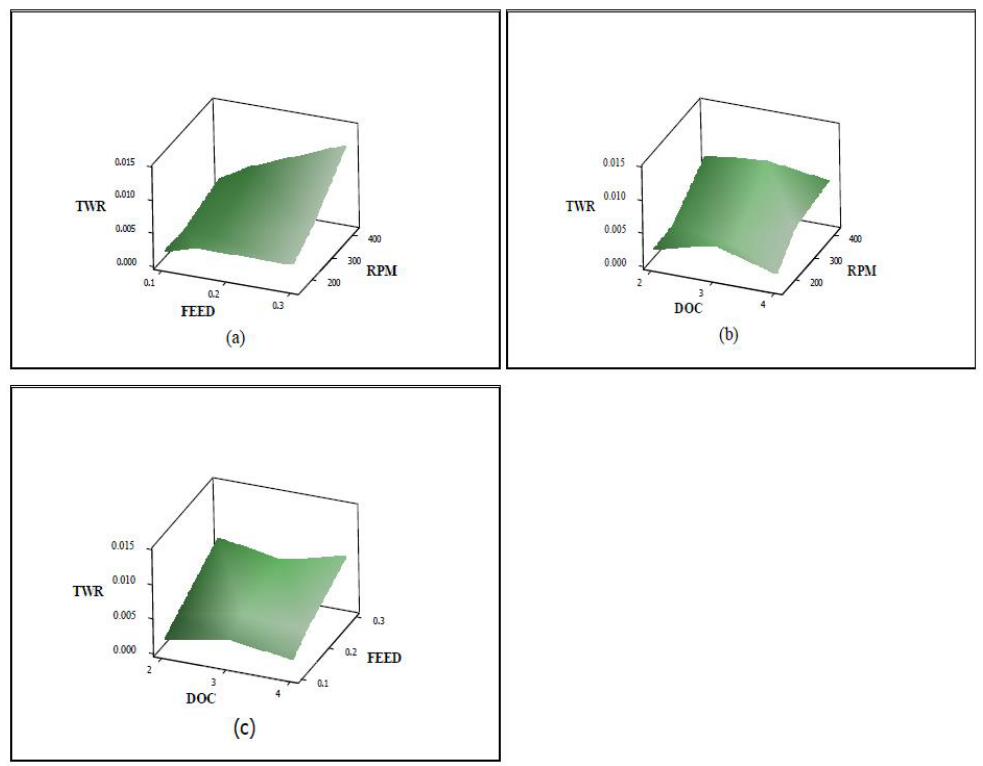
Figure 7. Surface plot of TWR ( a ) TWR Vs. f , N ( b ) TWR Vs. d , N ( c ) TWR Vs. d , f.